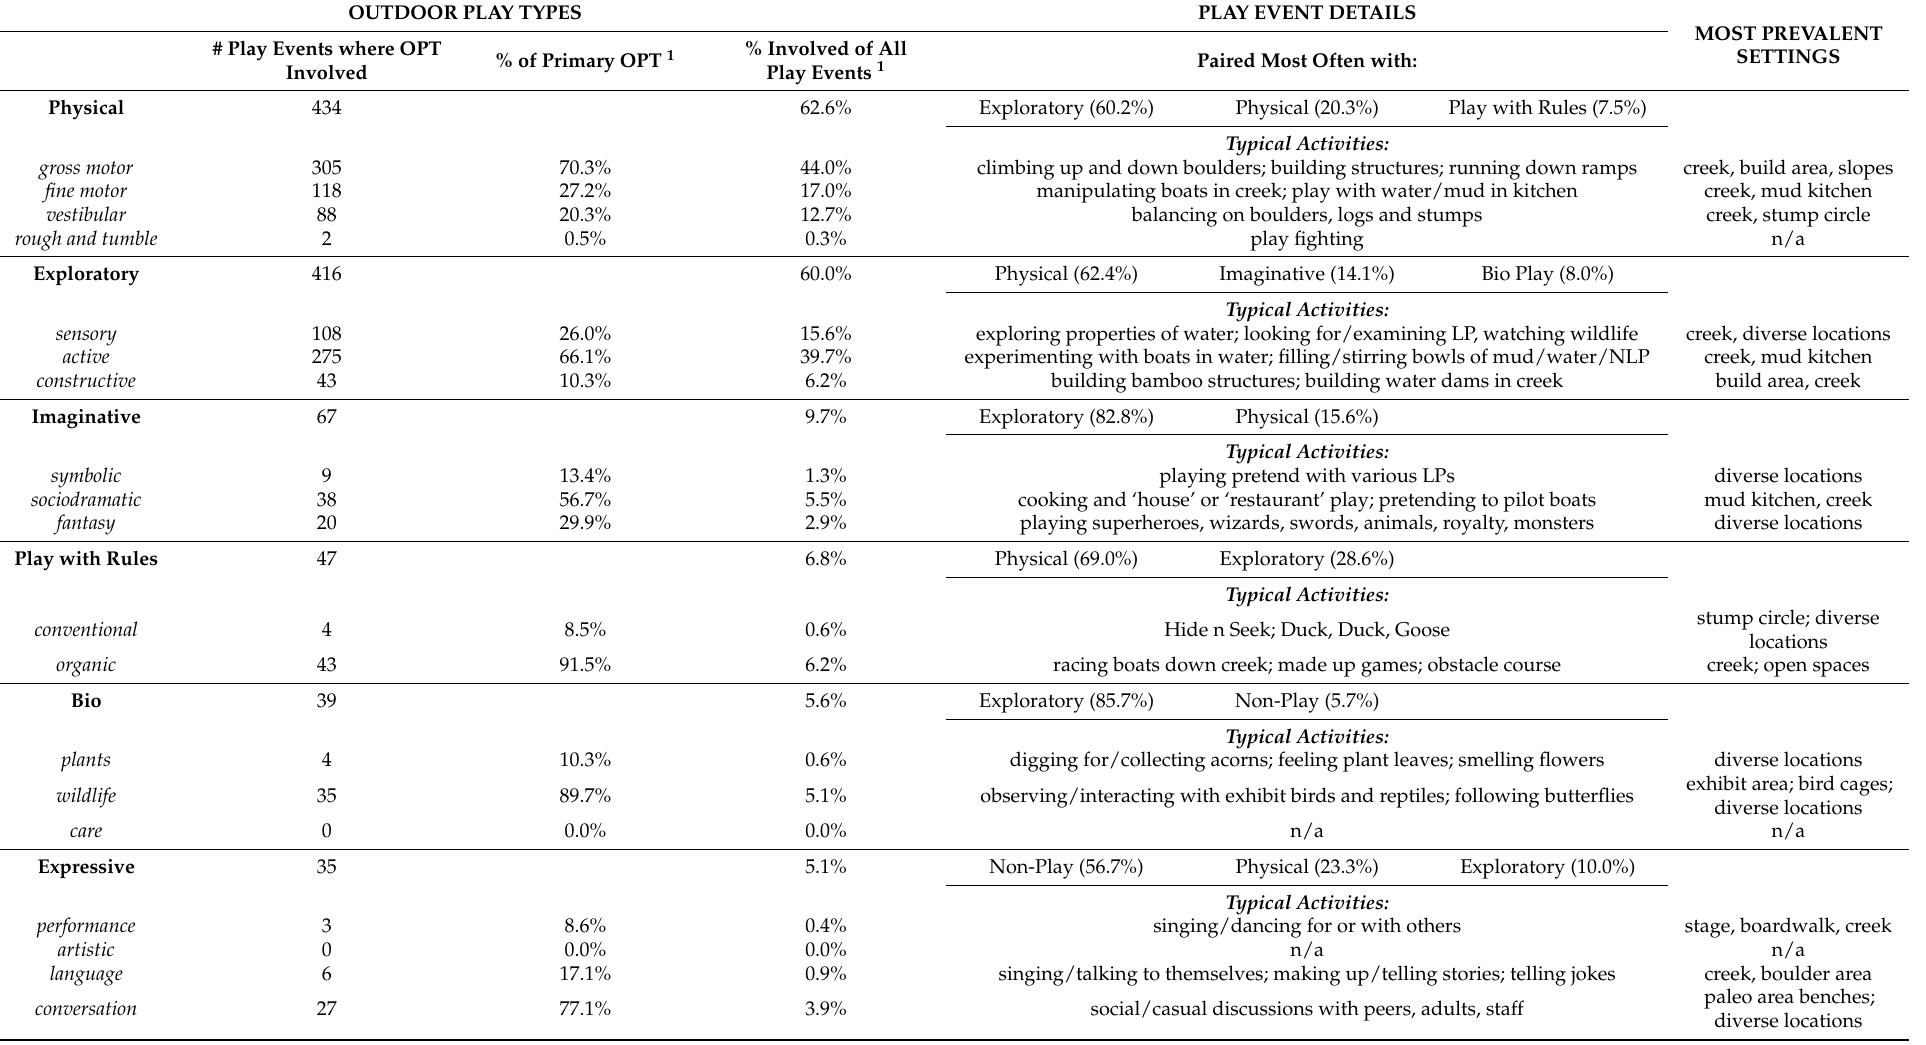
Table 2. Outdoor play type activity details and prevalent